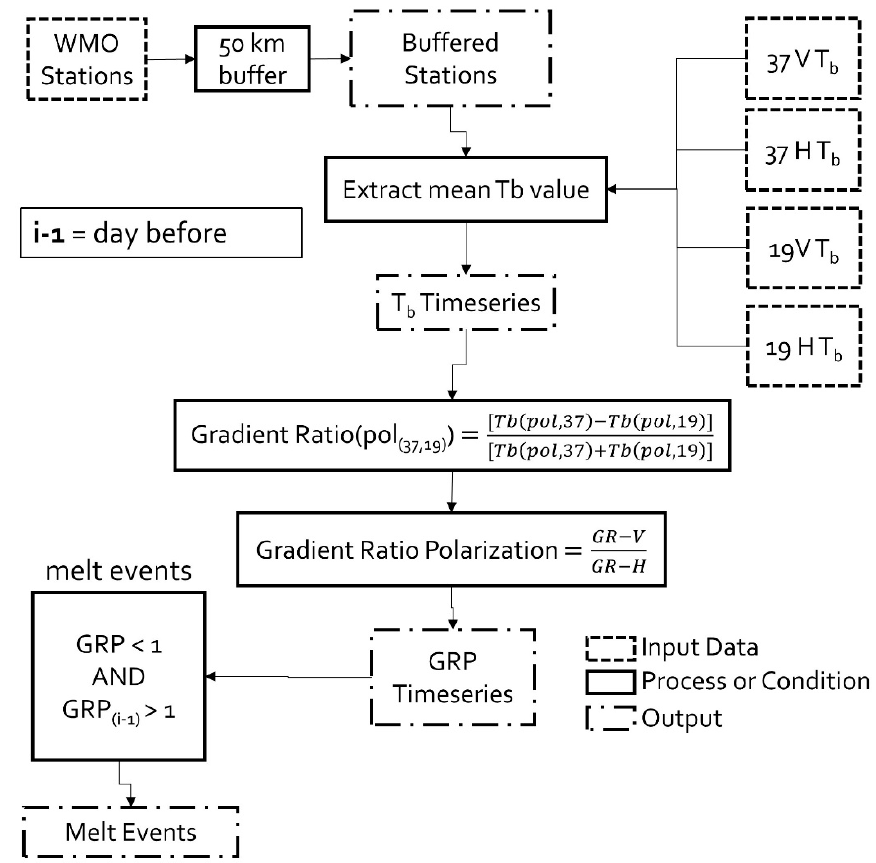
Figure 4. Workflow chart illustrating the steps required to detect surface melt events from the PMW T b retrievals. Each T b frequency (19, 37) and polarization (V, H) are averaged and processed separately before calculating the GRP Ratio.